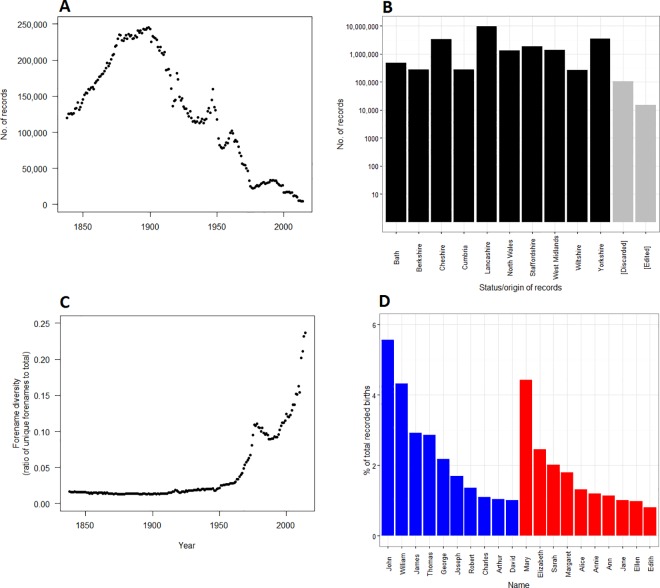
Overview of the primary data.(A) Number of usable records per year, and (B) per geographical region, along with the number of records edited and discarded. Edited records are those with typographic errors, and discarded records are those unrecognisable as names (detailed in S1 and S2 Tables, respectively). (C) Forename diversity per year, the number of unique forenames as a proportion of the number of births. (D) The top ten most popular male and female names across the entire dataset, ranked left to right. These rankings are affected by the disproportionately greater number of historical records. The most popular name in a given year is detailed in S6 Table.